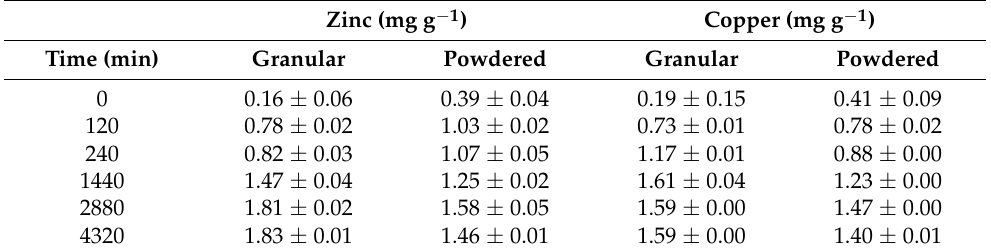
Table 1. Adsorption capacity of Zn 2+ and Cu 2+ metal ions in the adsorption process.